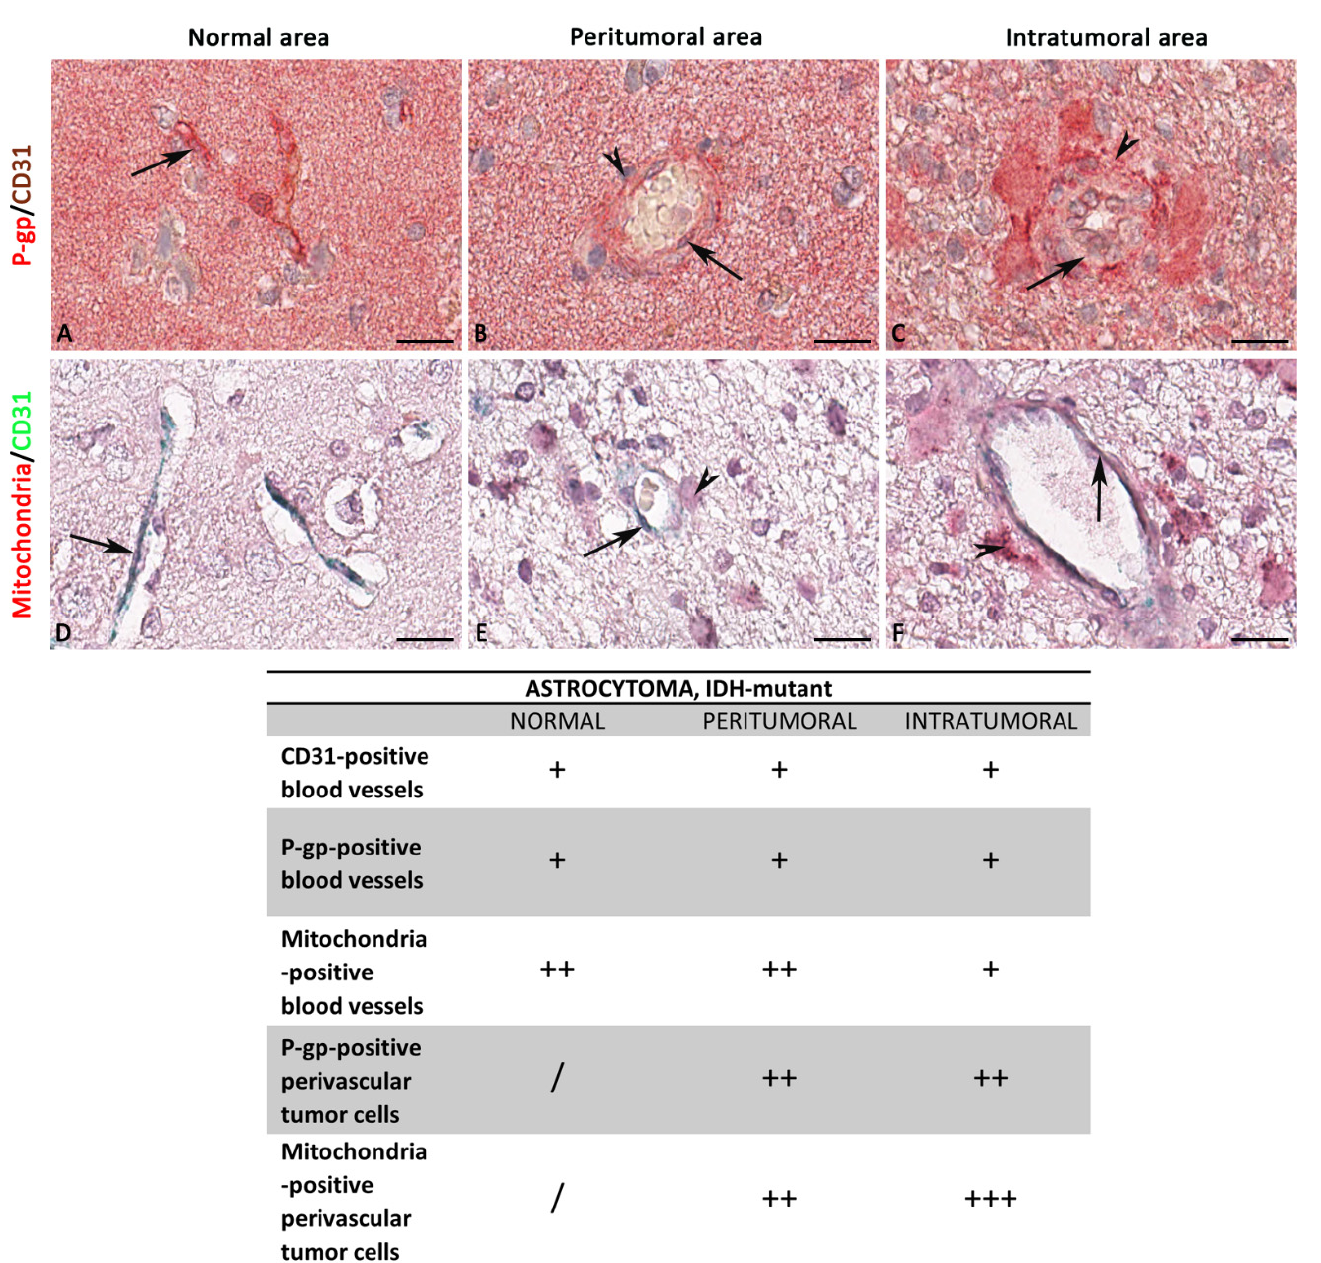
Figure 6. Focus on IDH-mutant astrocytoma blood vessels and tumor cells. High magnification of P-gp, mitochondria, and CD31 immunohistochemistry reactions, within the same spatial ROIs on IDH-mutant astrocytoma serial sections, and the summary table below show the differential expression of these markers by ECs and tumor cells. P-gp ( A – C ) and mitochondria ( D – F ) expression by tumor cells progressively increase from normal to intratumoral areas. Mitochondria + CD31-positive ECs show a reduced proliferative profile in the intratumoral area ( F ), while no relevant differences exist in P-gp expression by ECs. No relevant differences in CD31 expression also. The table shows the semi-quantitative scoring of IHC reactivity: “/”, very weak or absent; “+”, weak; “++”, intermediate; “+++”, strong. Arrows: ECs; arrowheads: tumor cells. Scale bar: ( A – F ) 16 µ m.